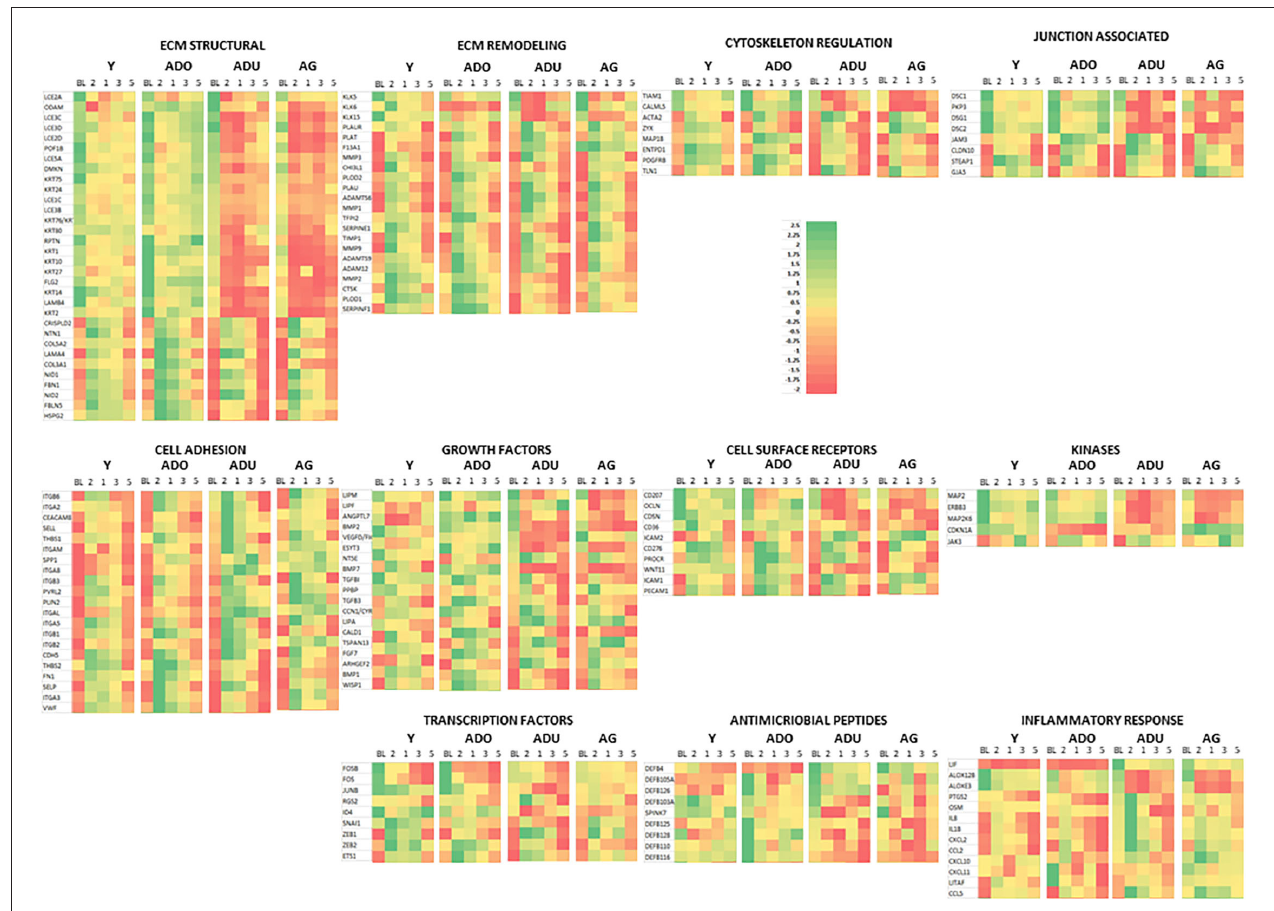
FIGURE 6 | Heatmap of genes in each functional category that were significantly different from baseline expression at disease and/or resolution samples. A z-score was determined across time points and within each gene.